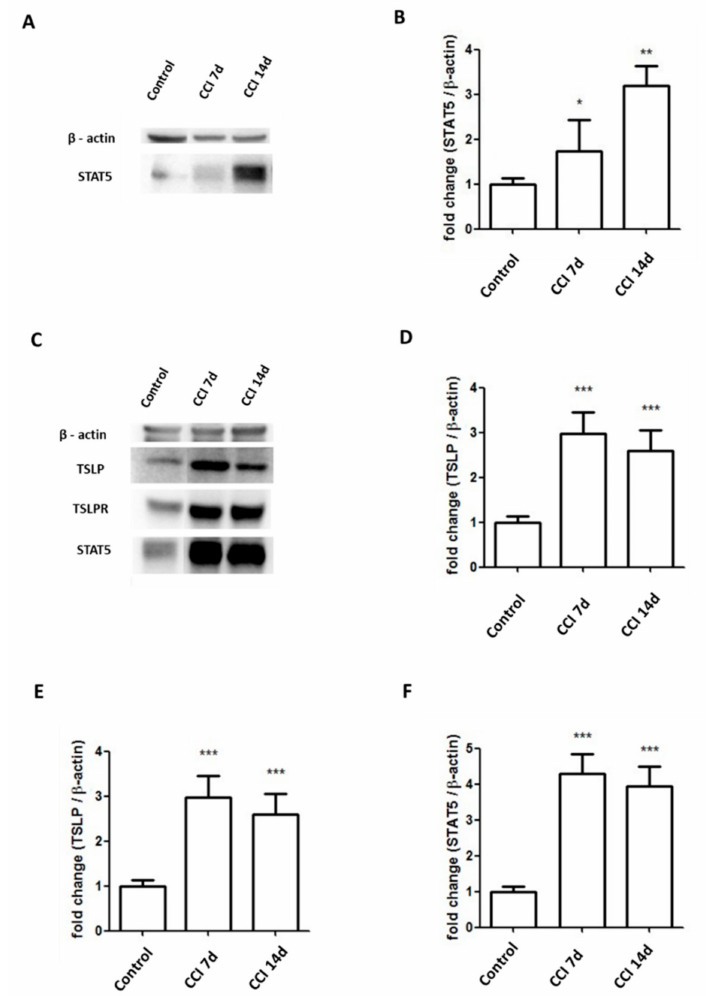
Figure 5. Expressions of STAT5 increased in sciatic nerve and DRGs in CCI rats. ( A , B ) Levels of STAT5 in the L4/5 DRGs of rats increased at 7 days and 14 days after CCI. Representative Western blot results. Each band density was quantitated, normalized with its own β -actin. ( C – F ) Levels of TSLP, TSLPR, STAT5 in the sciatic nerve of rats increased at 7 days and 14 days after CCI. Representative Western blot results. Each band density was quantitated, normalized with its own β -actin. Values are presented as means ± SEM. N = 6 for each group. * p < 0.05, ** p < 0.01 and *** p < 0.001 vs. control group analyzed by ANOVA